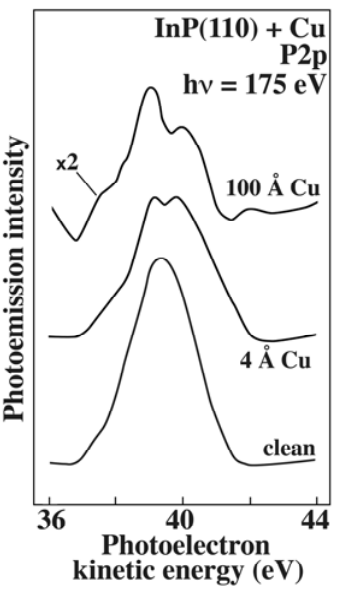
Figure 6. Photoemission spectra of a clean InP surface (bottom) and of the same surface covered by two different thicknesses of copper. The spectra show the P2p core level, revealing the presence of phosphorus and then the lineshape changes that reflect the modifications in the chemical bonding situation of the phosphorus atoms at the surface. Data from